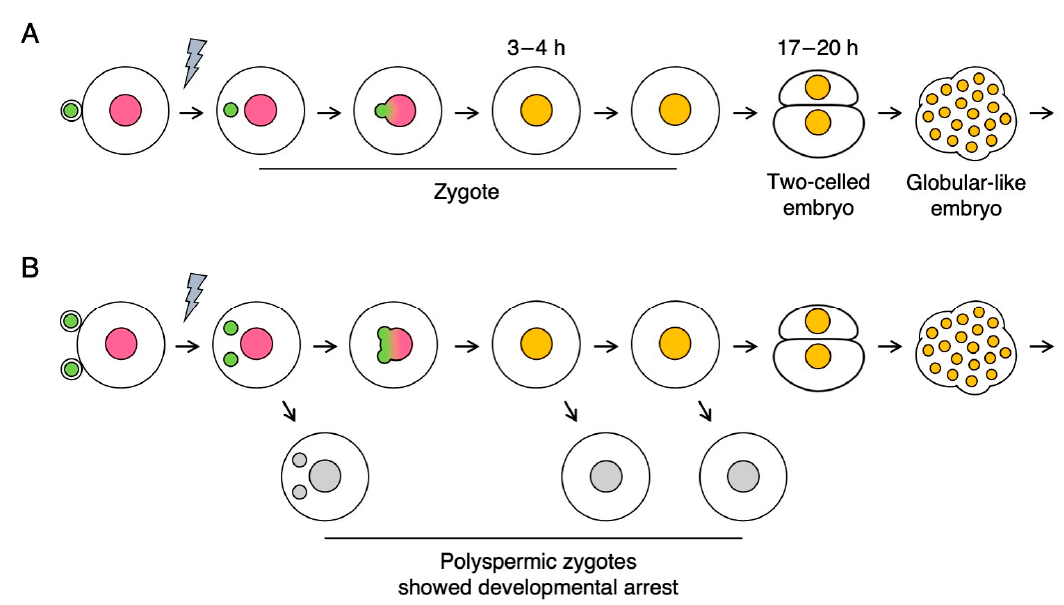
Figure 3. Schematic diagram of the early development of the diploid zygote ( A ) and polyspermic zygote ( B ). The times required for the completion of karyogamy (ca. 3–4 h) and the first cell division (ca. 17–20 h) are provided. Pink, green, and orange circles indicate the egg, sperm, and zygotic nuclei, respectively. Gray circles indicate the egg, sperm, and zygotic nuclei in the polyspermic zygotes that exhibited arrested development. The gray flash symbols represent